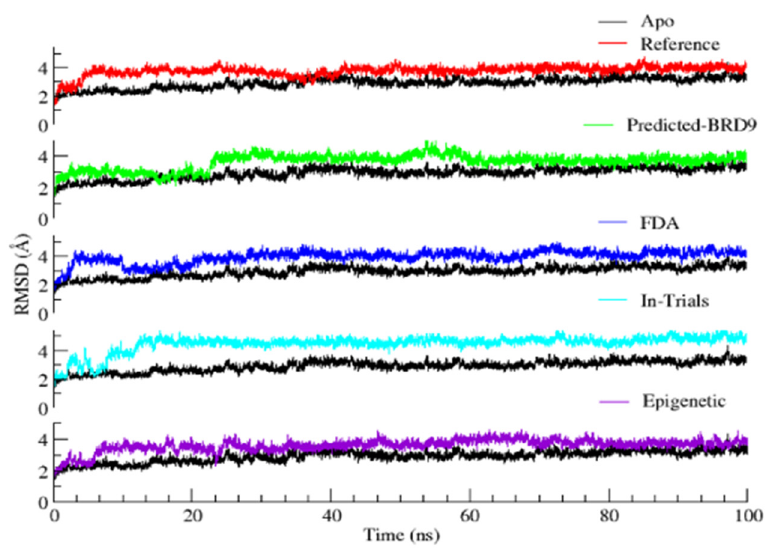
Figure 11. Root mean square deviation (RMSD) of backbone atoms in BRD9 relative to the corre- sponding Apo (black) and reference compound (red); ZINC433599781 ZINC28232750 (blue); ZINC2036848 (cyan); ZINC95589781 (purple).